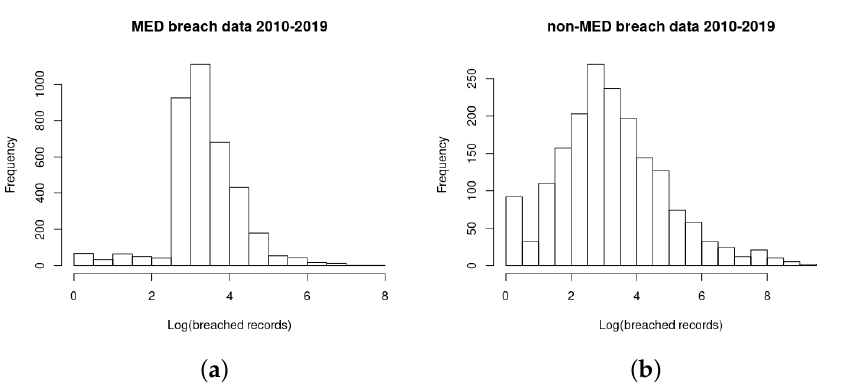
Figure 1. Empirical distribution of the (logarithm of the) number of breached records, assumed to be a measure of the breach severity for ( a ) MED type organizations and ( b ) all but MED type organizations. Data reported in the PRC dataset in the time period